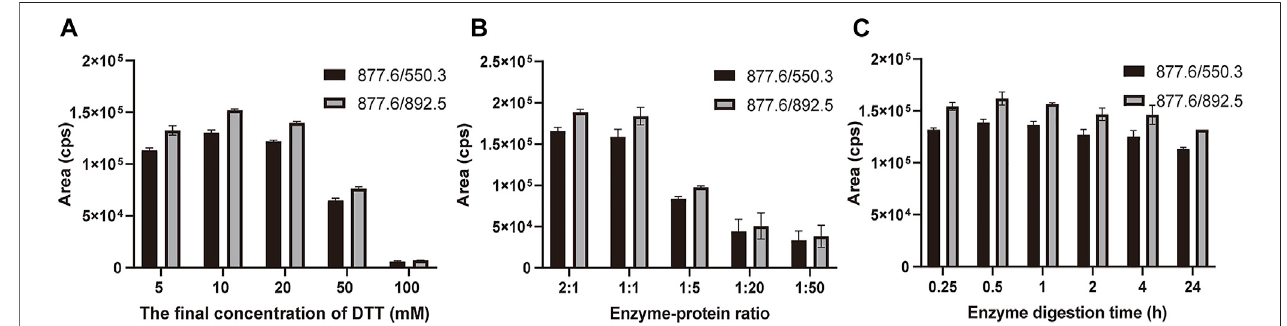
FIGURE 4 | Optimization of digestion conditions. (A) Final concentration of DTT reduction (5, 10, 20, 50, and 100 mM) and alkylation with iodoacetamide (DTT-IA ration 1:2). (B) Enzyme-protein ratio (2:1, 1:1, 1:5, 1:20, and 1:50). (C) Enzyme digestion time (0.25, 0.5, 1, 2, 4, and 24 h) with trypsin at 37 ° C. Bars are mean ± SE ( n = 3).